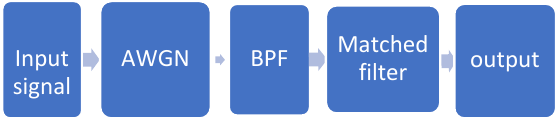
Figure 1. Block diagram of the matched detector technique .